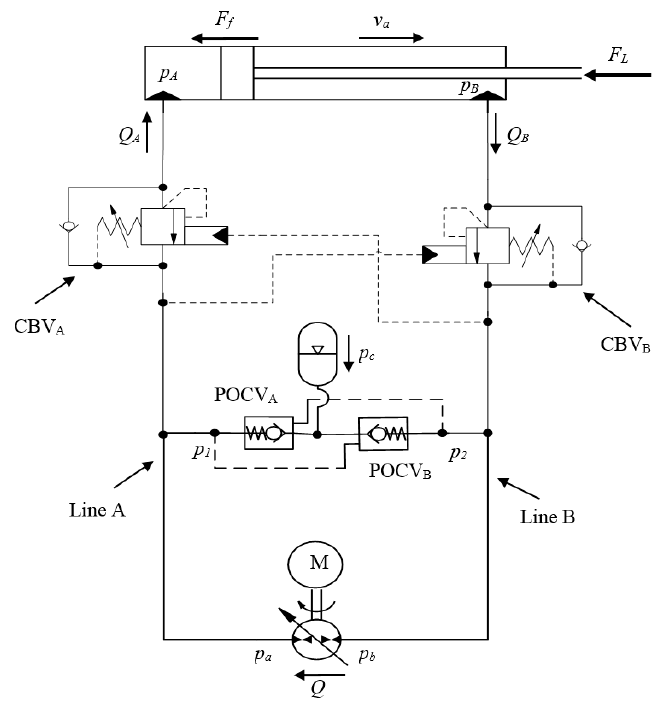
Figure 8. Proposed circuit implementation utilizing two CBVs.